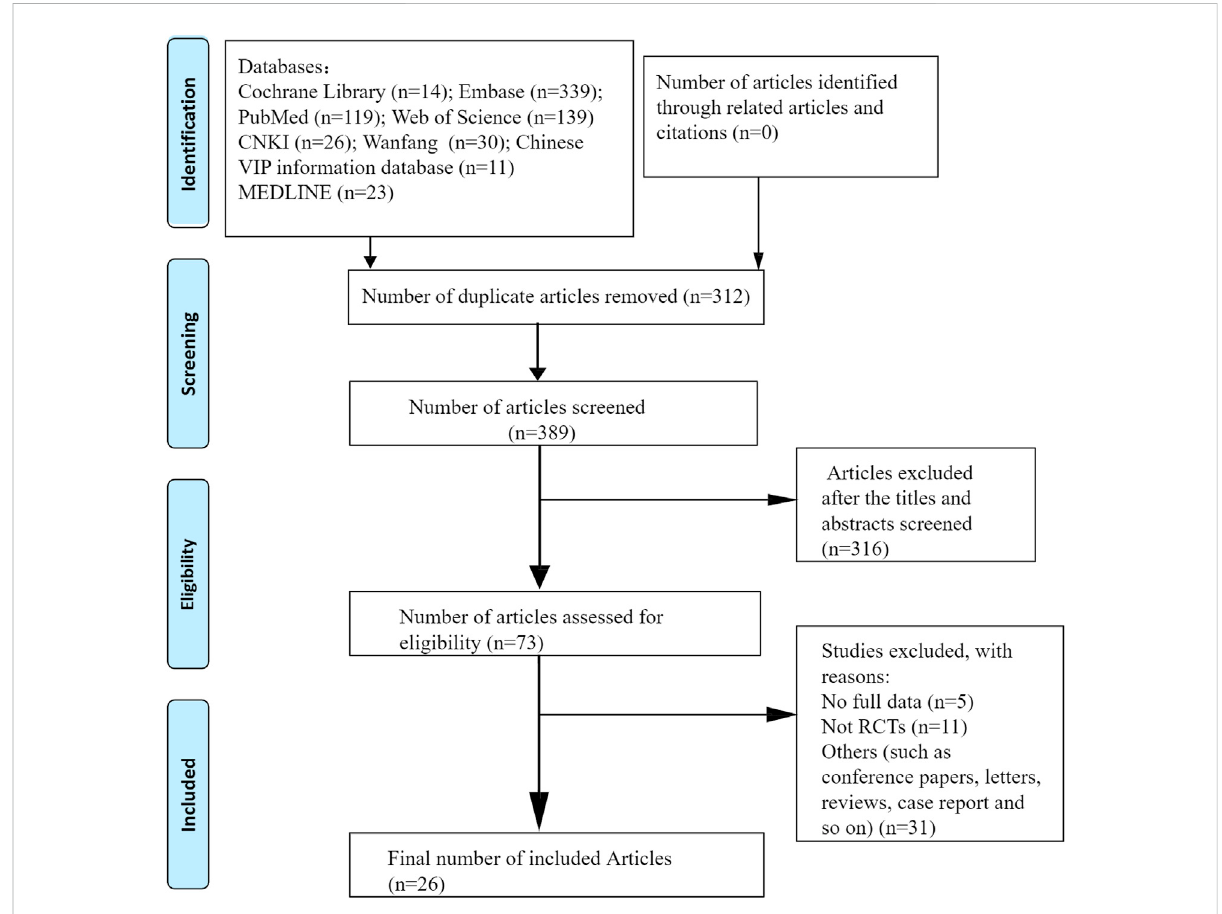
FIGURE 1 Flow diagram according to PRISMA (Preferred Reporting Items for Systematic Reviews and Meta-analyses)